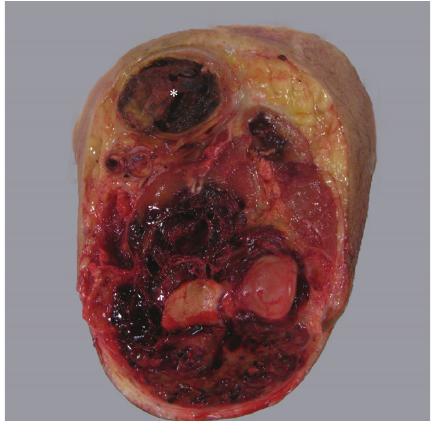
Figure 2: Gross examination, amputation specimen. The AVG site (asterisk) in the antecubital region exhibits a dilated space distended with tumor, which radiologically was thought to be thrombus within a pseudoaneurysm. Tumor envelopes the elbow and tracks distally into the